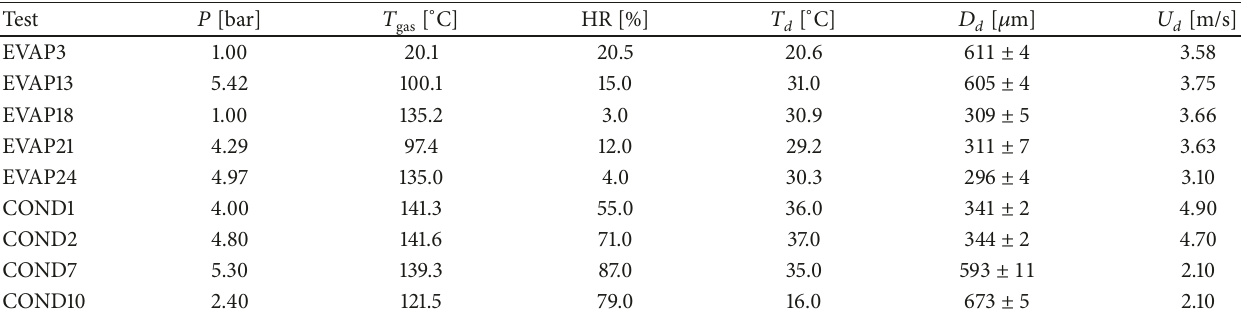
Table 2: Mean values for the gas characteristics and for the droplet initial